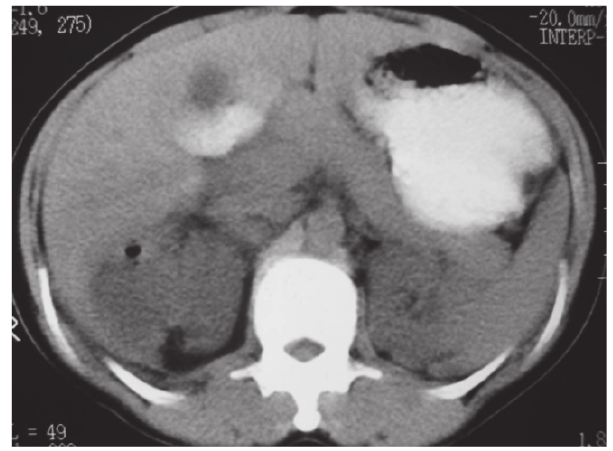
Figure 1 - Computed tomography image of the abdomen showing a gas- containing fluid collection in the inferior portion of the right hepatic lobe, suggesting an infected collection. Abdominal ultrasound revealed a 9.9 x 6.7 x 7.6-cm heterogenic mass in the inferior portion of the right hepatic lobe in close contact with the right